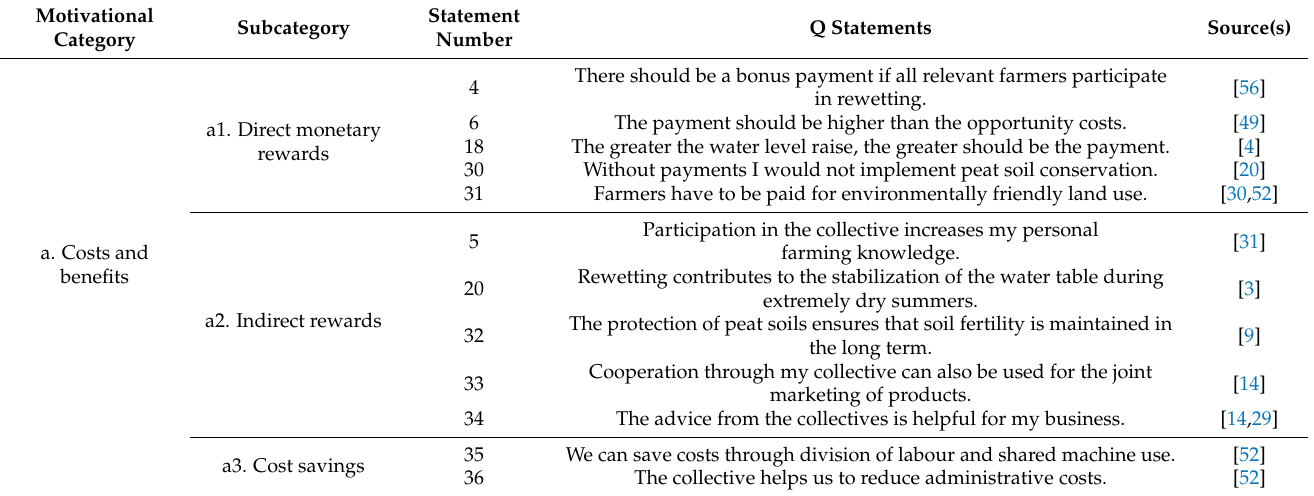
Table A1. Categories of farmers’ motivation from [38], for participation in cooperative AECMs and corresponding Q